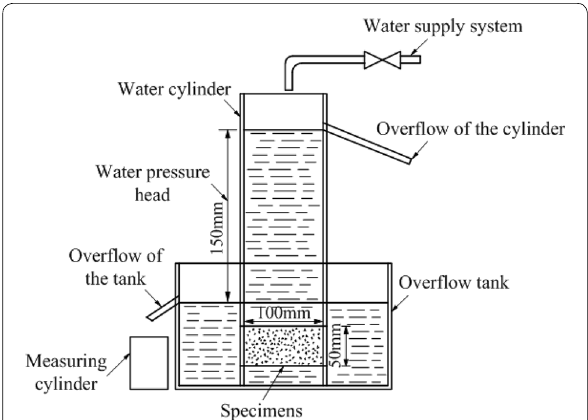
Fig. 2 Schematic diagram of the permeability coefficient test